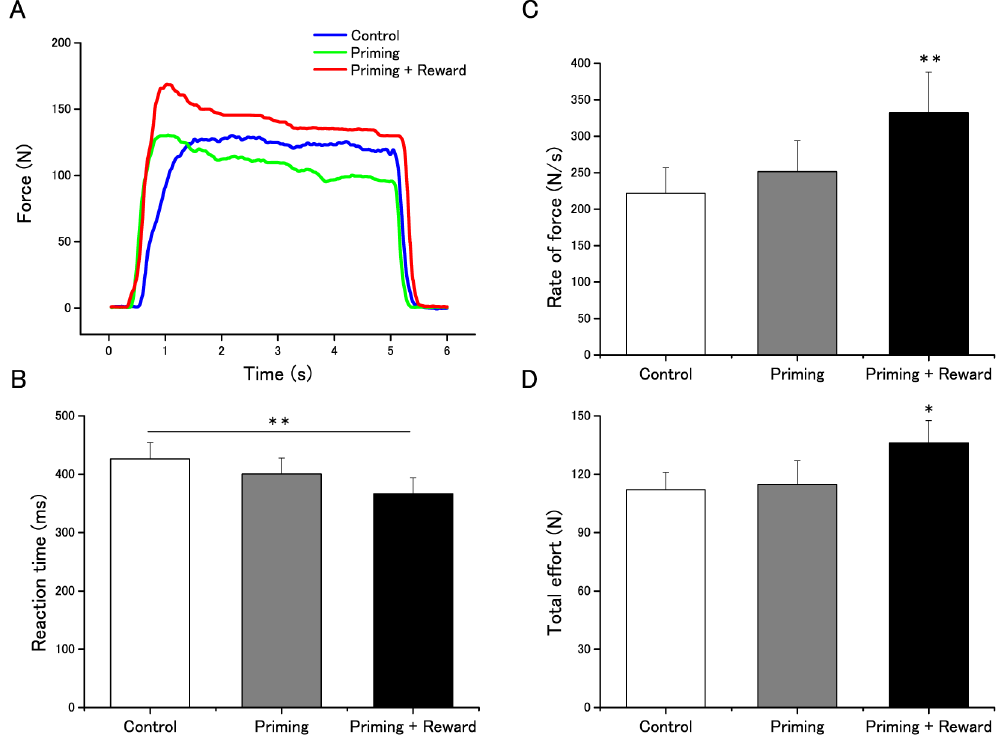
Figure 2. Effects of barely conscious goal pursuit on motor action. A: Typical recordings of hand-grip force after three experimental conditions. B, C, D: Reaction time (B), Rate of force (C), and Total effort (D) for the three conditions. Data are expressed as mean 6 SEM. The asterisks in panel B indicate statistically-significant differences between the control and the priming-plus-reward conditions, and the asterisks in panels C and D indicate statistically -significant differences compared with other conditions (* p , 0.05, ** p , 0.01).